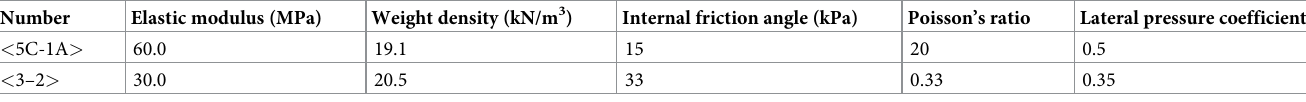
Table 1. Details of the soil conditions surrounding the karst cave studied in this project [35].